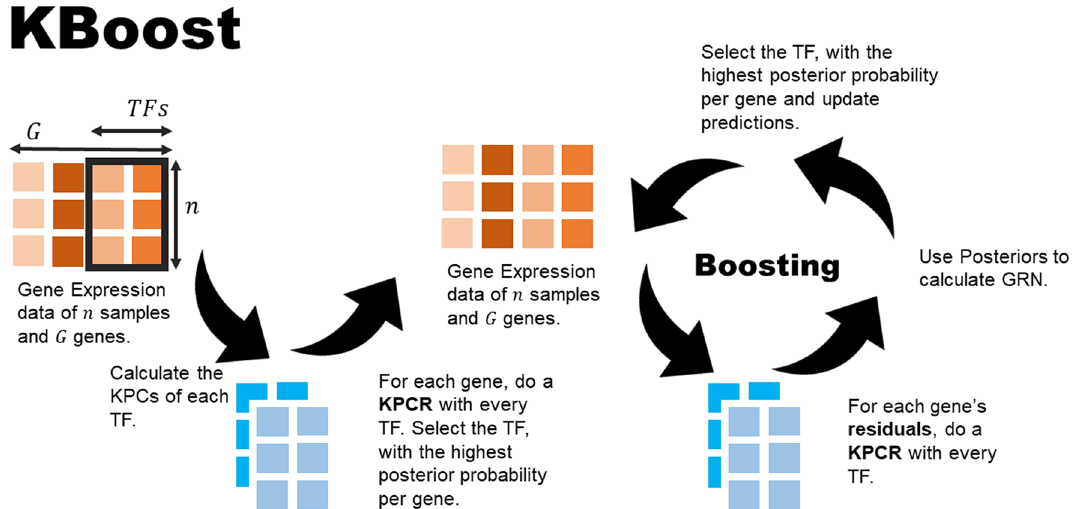
Figure 3. Gene Expression Modelling with KPCR and Boosting. The procedure starts by selecting the TF whose KPCR model has the highest posterior for each gene. Then we combine different KPCR models by boosting. At each boosting iteration we fit a new KPCR model to each gene expression’s residuals instead of the actual values. We then select the TF whose KPCR model has the highest performance in each case and update the KPCR model